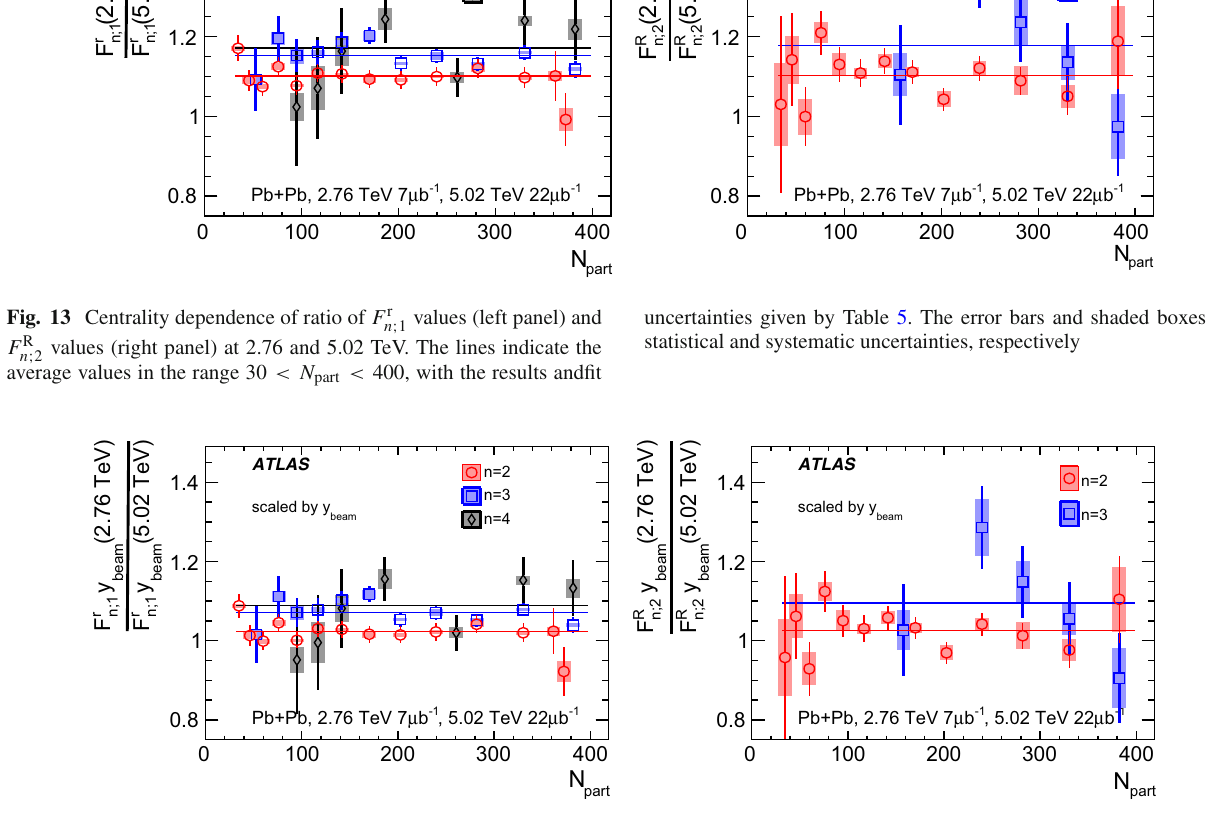
≡ F r Fig. 14 Centrality dependence of ratio of ˆ F r y beam val- 30 < N part < 400,withtheresultsandfituncertaintiesgivenbyTable5. n ; 1 n ; 1 The error bars and shaded boxes are statistical and systematic uncer- ≡ F R y beam values (right panel) at 2.76 ues (left panel) and ˆ F R n ; 2 n ; 2 tainties, respectively and 5.02 TeV. The lines indicate the average values in the range